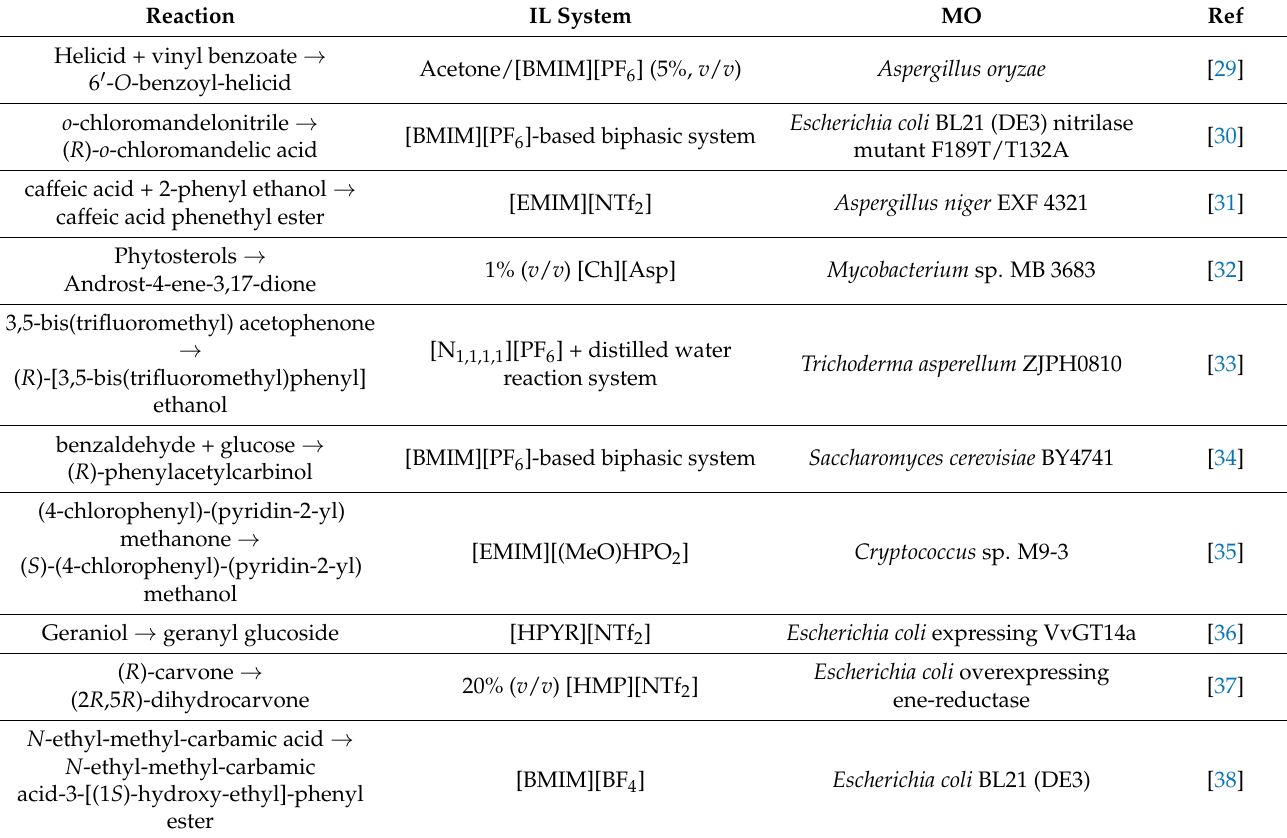
Table 1. Examples of the application of ionic liquids within whole-cell biocatalytic